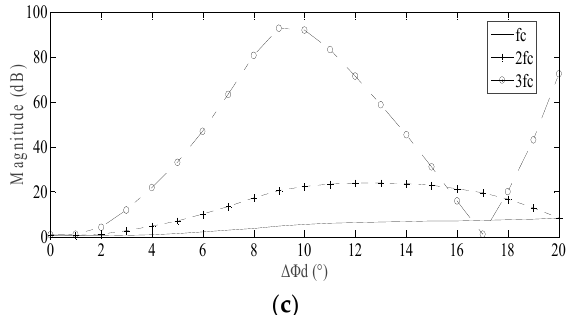
Figure 7. Amplitude trend of f c , 2 f c and 3 f c for di ff erent spall length when the motor speed is varied respectively: ( a ) Motor speed n = 150 r / min; ( b ) Motor speed n = 300 r / min; ( c ) Motor speed n = 450 r / min.